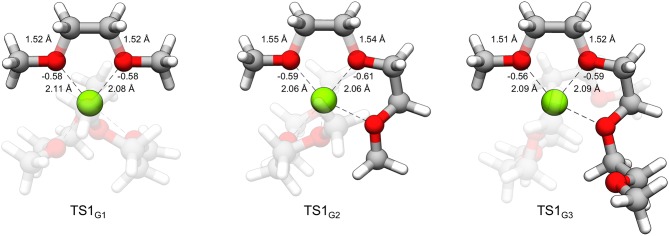
TS1G1, TS1G2, and TS1G3 with labeled C-O bond lengths, O···Mg2+ interaction distances and natural atomic charges critical to the distortion and interaction energies comprising the difference in decomposition barrier heights. The charges for oxygen were obtained for the geometry of the glymes of the complex in the absence of Mg2+ and assigned an overall charge of –1.